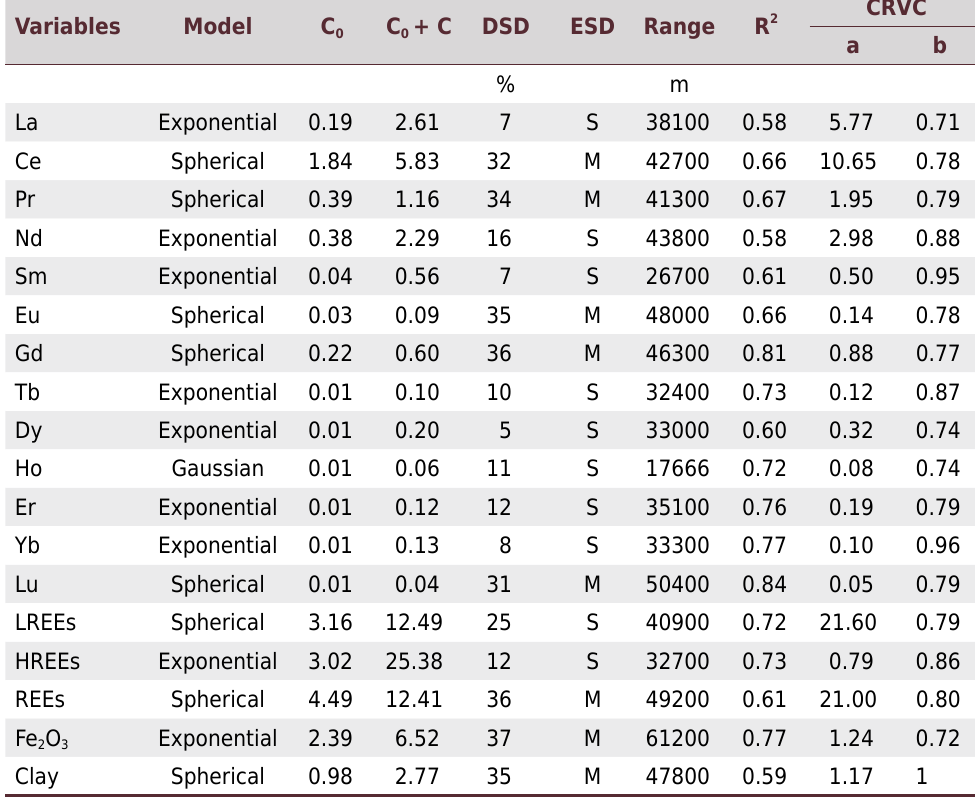
Table 5. Estimated models and parameters of the semivariograms of rare earth elements (REEs), iron